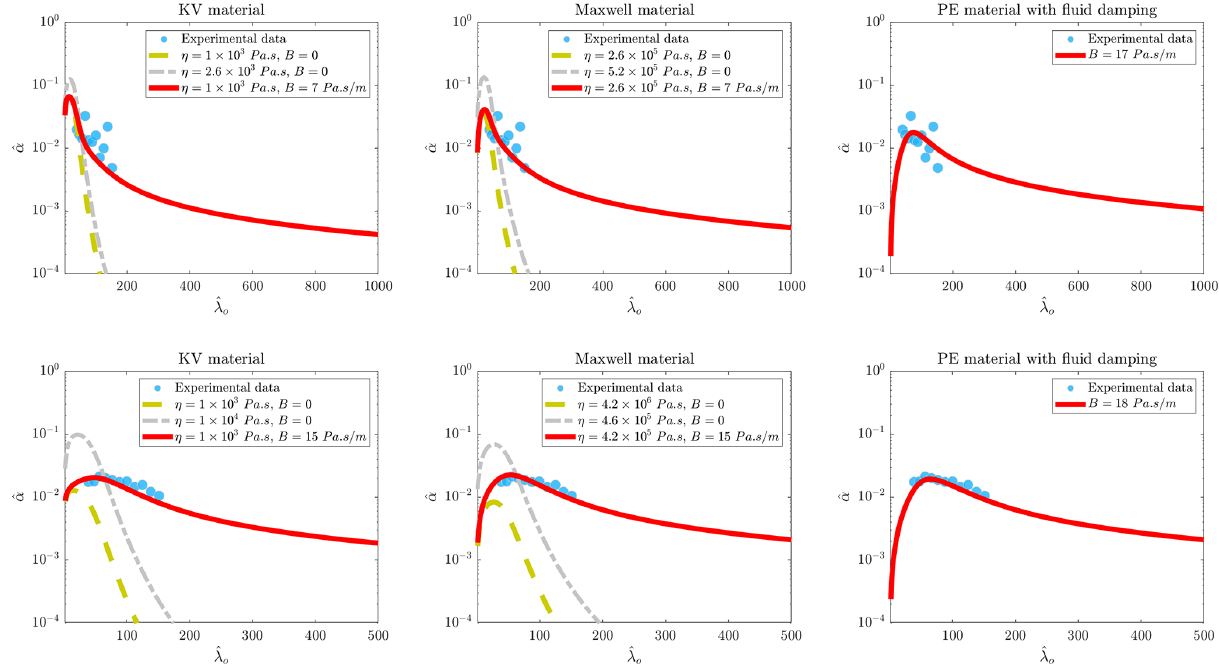
Figure 8. Comparison between ˆ α vs. ˆ λ o curves predicted by models and the data measured by Sree et al. (2018). Upper and lower rows show the data related to a cover with a shear modulus of 20 and 80KPa respectively.